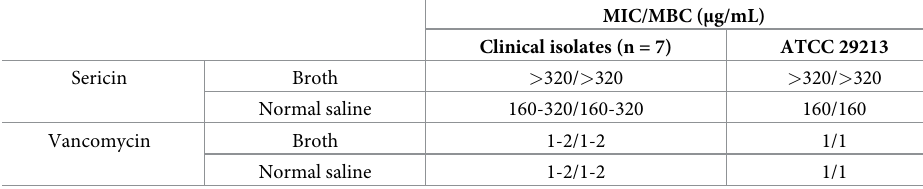
Table 2. Antibacterial activity of sericin extract and vancomycin against S . aureus when prepared bacterial inocu- lum with broth or normal saline.